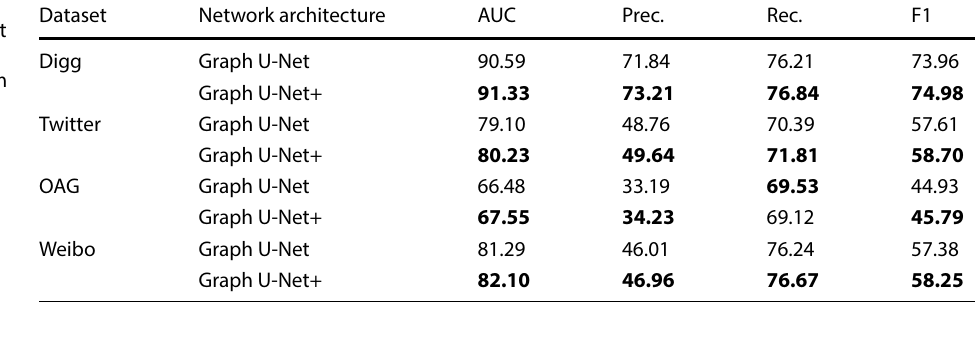
Table 5 Based on the experiment in Table 4, we only change the GCN layer of graph U-Net+ into GCNII layer ( %